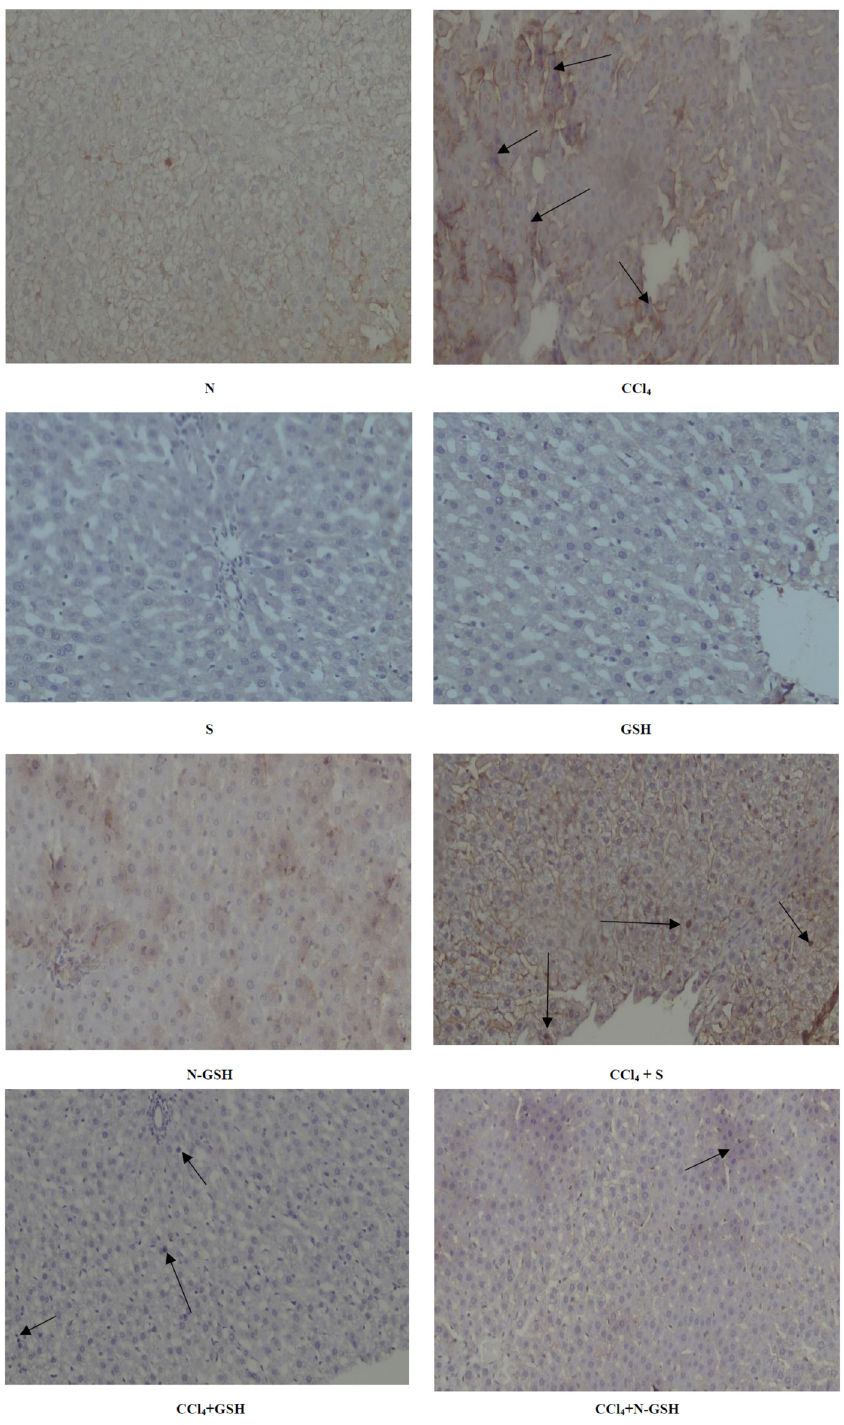
Figure 8: Immunohistochemistry results of NF - K β on hepatic tissued of N, normal rats; CCl 4 , treated rats; S, silymarin - treated rats; GSH, glutathione - treated rats; N - GSH, nano - glutathione - treated rats; CCl 4 + S, CCl 4 + silymarin - treated rats; CCl 4 + GSH, CCl 4 + glutathione - treated rats; and CCl 4 + N - GSH, CCl 4 + nanoglutathione - treated